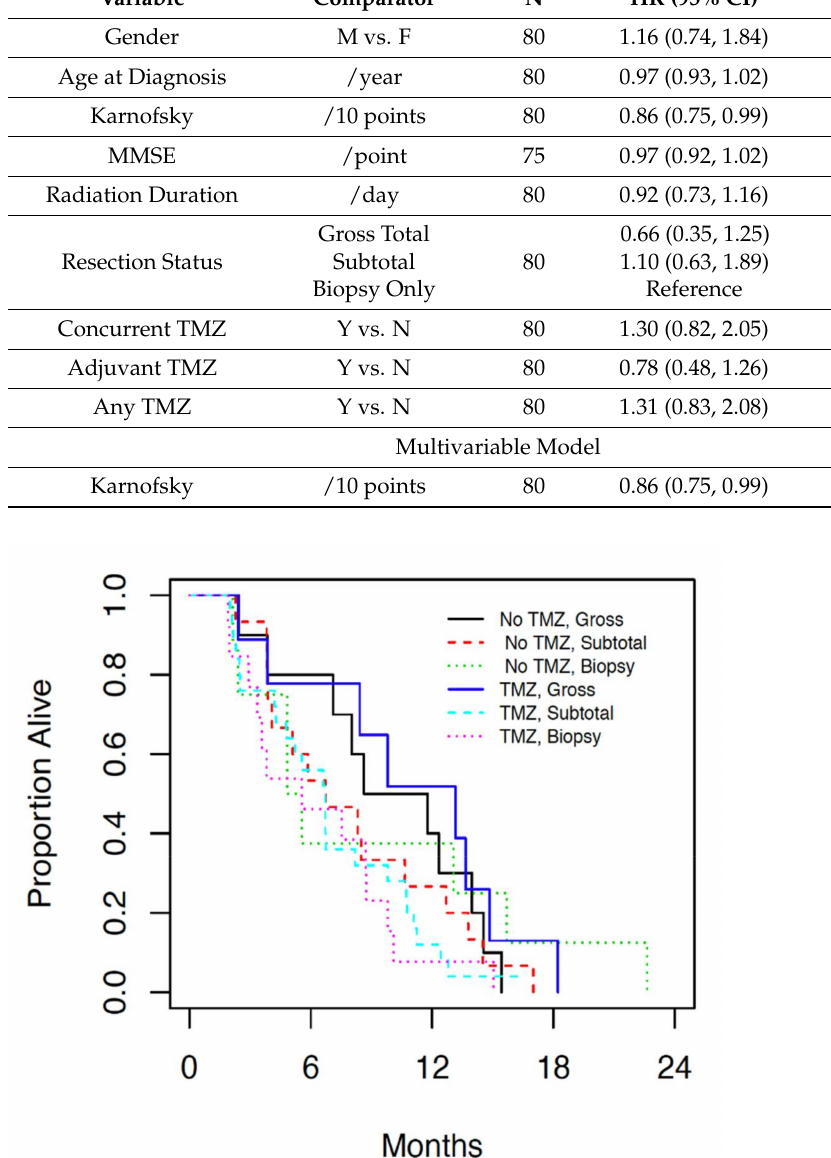
Figure 2. Median overall survival in patients who were treated with radiation alone (No TMZ) and chemoradiation (TMZ) subdivided further by extent of surgical